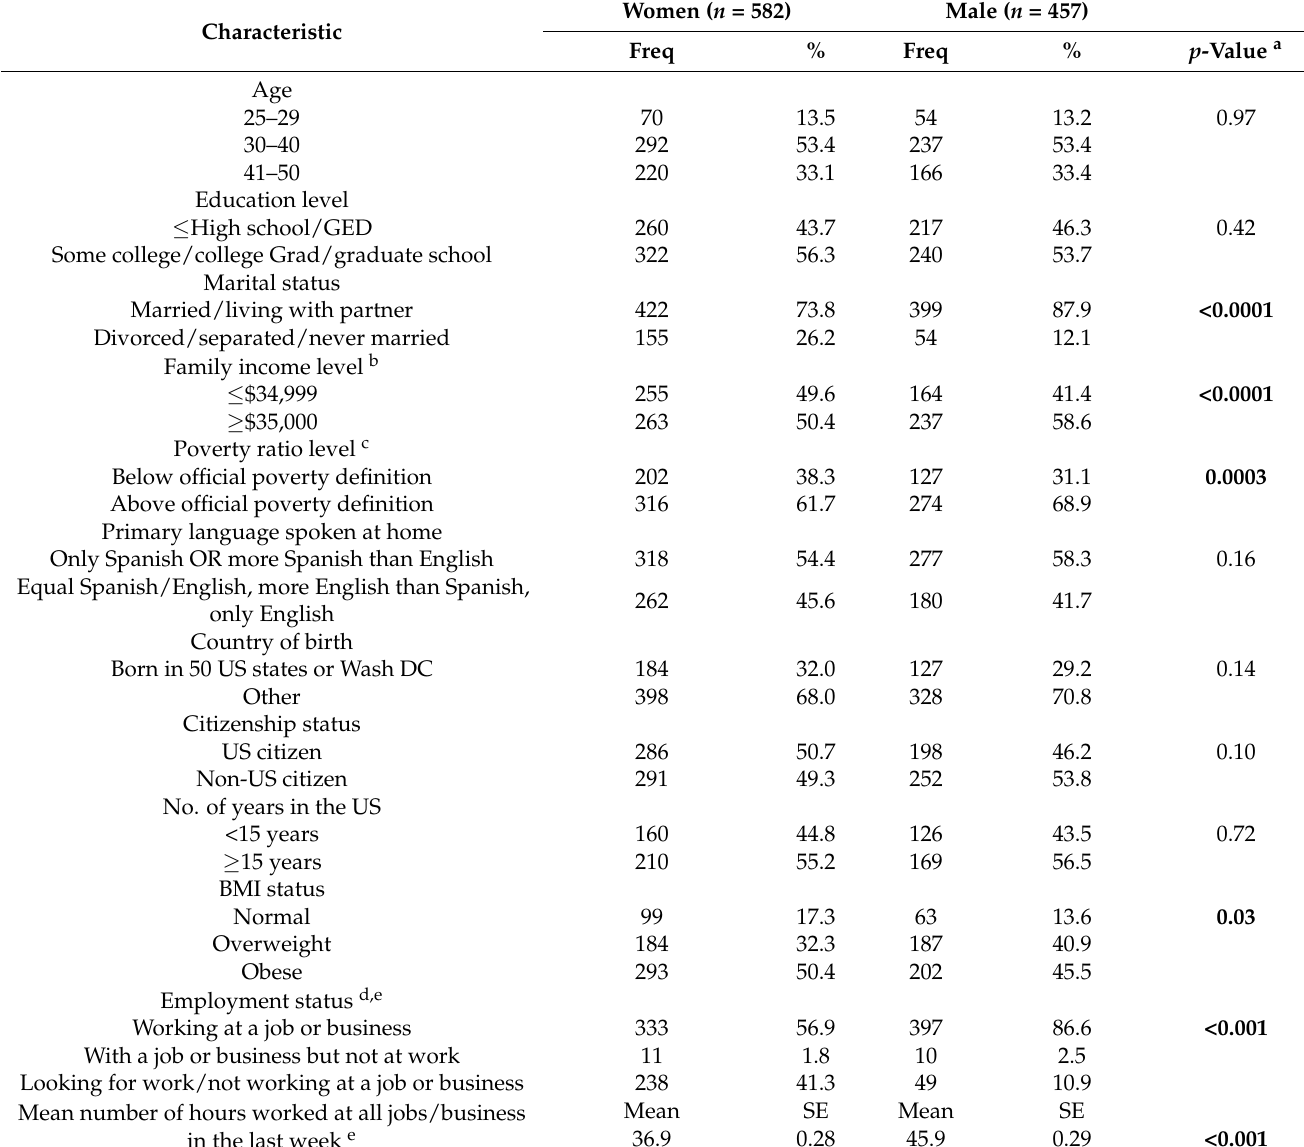
Table 1. Sociodemographic characteristics and BMI (Body mass index) status for women and